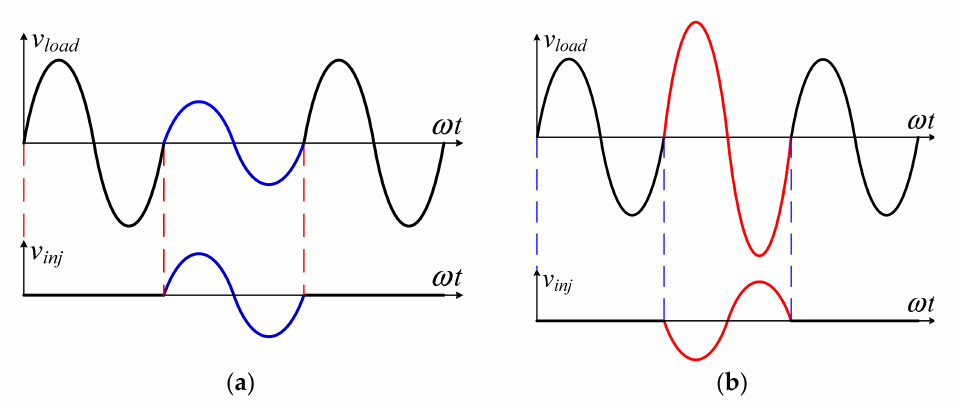
Figure 2. Voltage compensation during ( a ) voltage sag event and ( b ) voltage swell